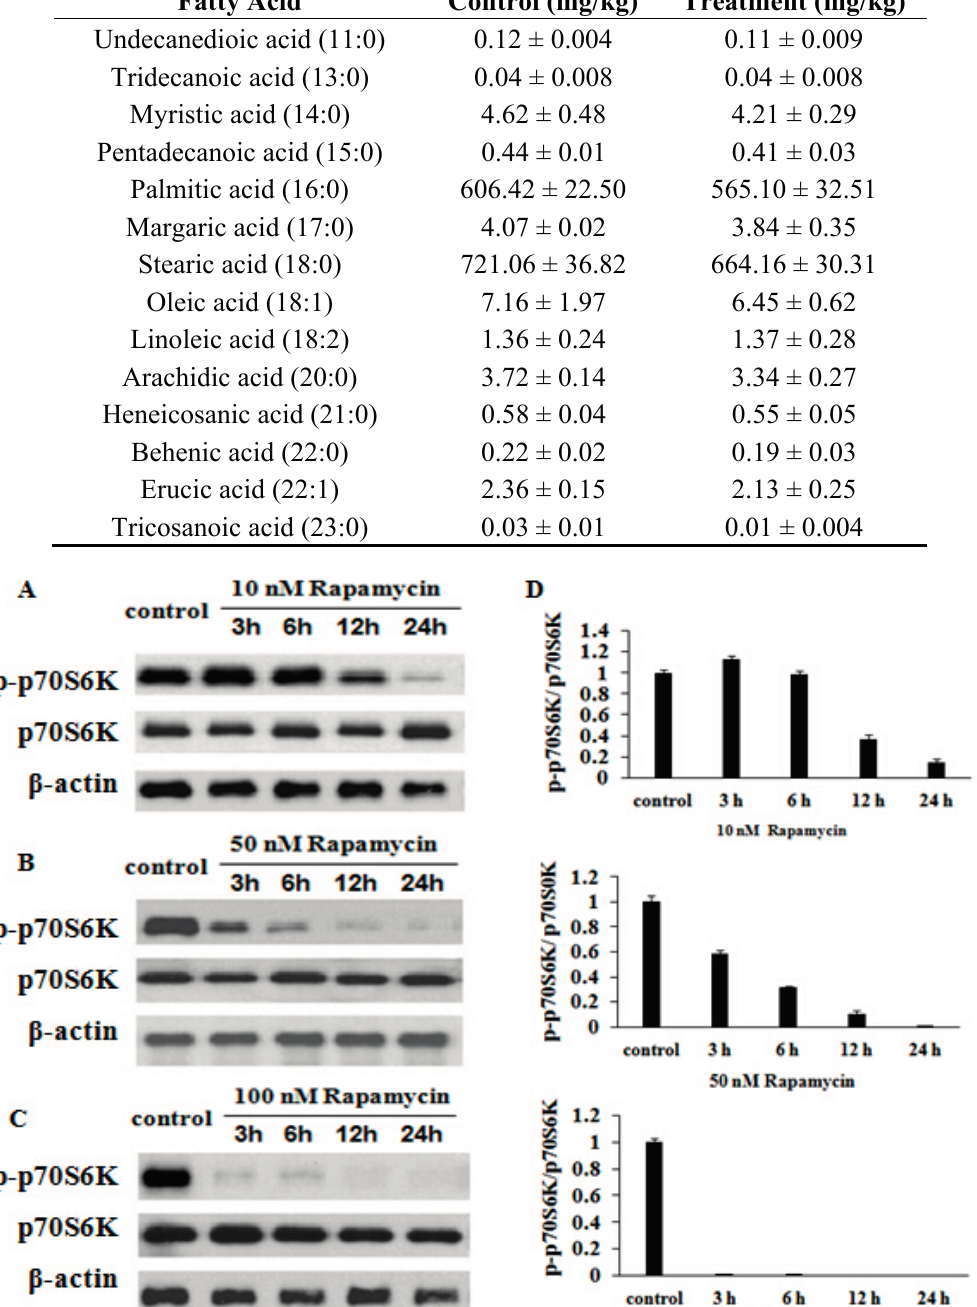
Table 1. Content of fatty acids in control and rapamycin-treated cells.